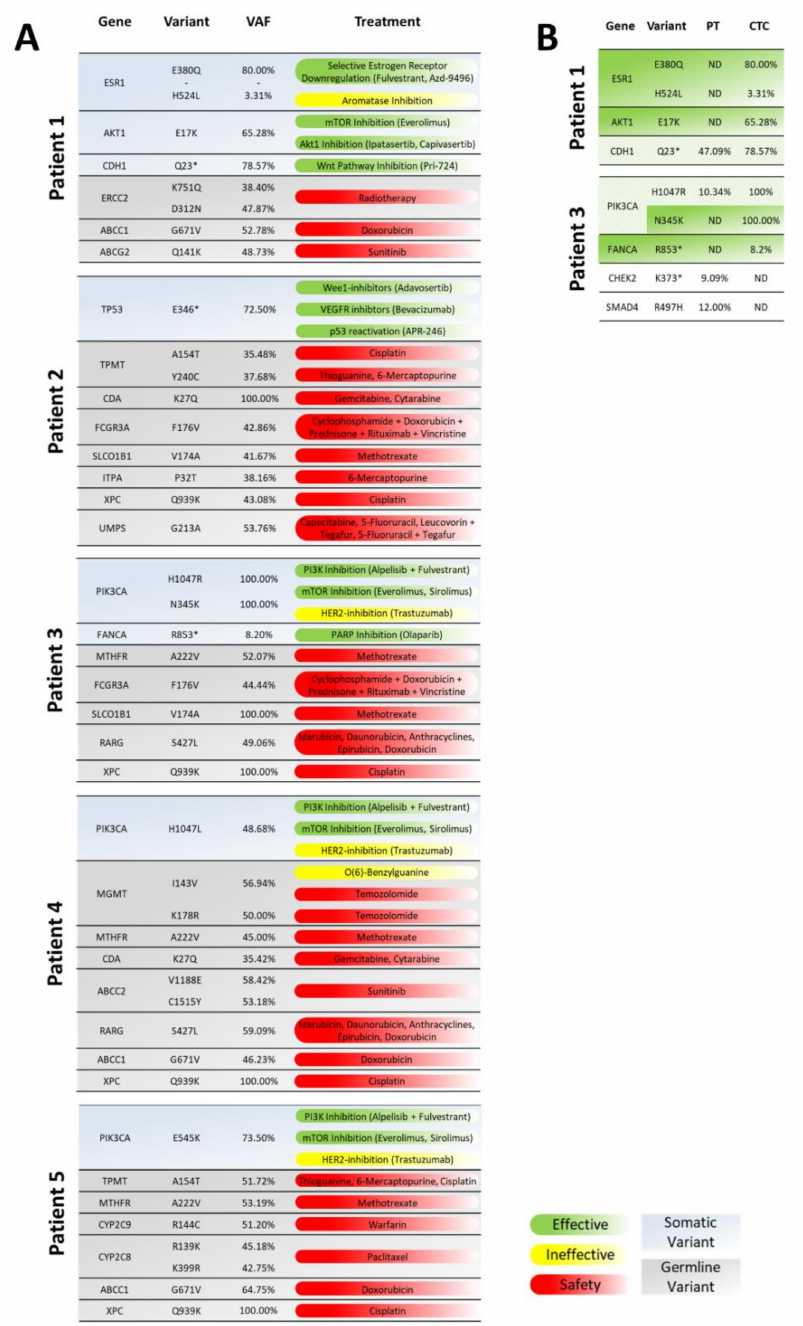
Figure 1. Mutations detected by whole-exome sequencing (WES) of circulating tumor cells (CTCs) and the therapies targeting them: ( A ) Only clinically relevant mutations detected in the CTCs are shown. The second exon of the AKT1 gene was not covered in the WES of all WGA samples. Because this exon contains amino acid E17, frequently mutated in metastatic breast cancer, it was sequenced also with targeted Sanger sequencing (Supplementary Figure S2). For each detected mutation, treatments and their efficacies and safety concerns are listed (effective: potentially effective treatment option; ineffective: potentially ineffective treatment; safety: potential safety concern). ( B ) Concordance of mutations between primary tumor (PT) and CTCs. Only clinically targetable mutations are listed. Variants that were detected only in CTCs but not in the PT are shown in green. Variants that were detected in a minor subclone of the PT compared to the CTCs are indicated in green hatched. nd (not